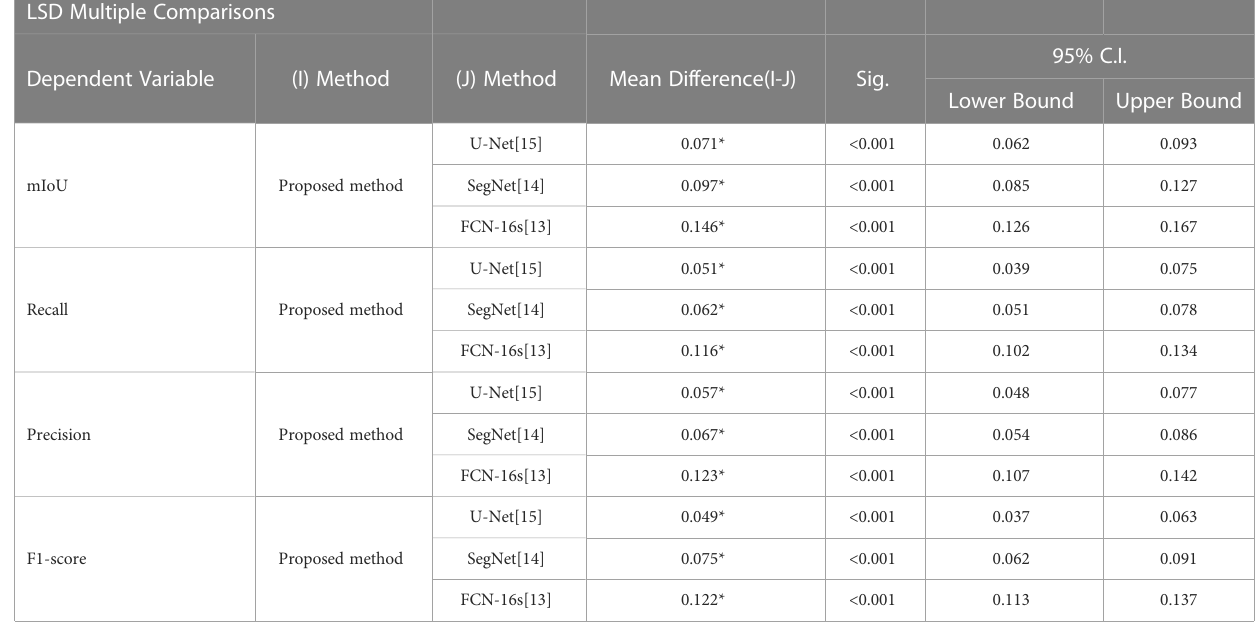
TABLE 5 Multiple comparisons of CT lung nodule segmentation results: LSD